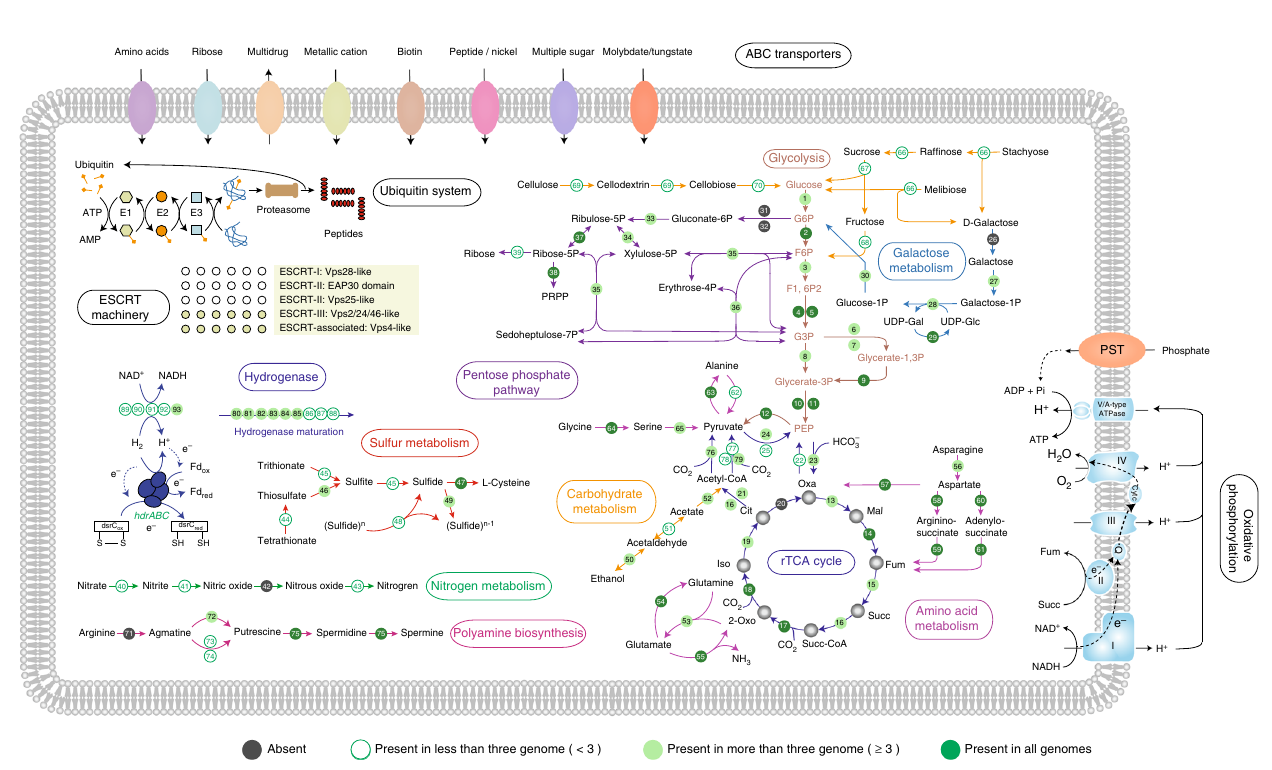
Fig. 2 Overview of metabolic potentials in Aigarchaeota. Genes related to glycolysis, galactose metabolism, roTCA cycle, the pentose phosphate pathway, the pyruvate metabolism, beta-oxidation of fatty acids, oxidative phosphorylation chain, protein biosynthesis-related pathway, membrane transporters, and ubiquitin system are shown. Green solid circles represent genes present in all six aigarchaeal genome bins. Green hollow circles represent genes occurring in one to fi ve bins. Gray solid circles represent genes absent in all bins. For full names and copy numbers of the genes in number see Supplementary Data 1. roTCA reversed oxidative tricarboxylic acid cycle; ESCRT the endosomal sorting complexes required for transport, G6p glucose 6-phosphate, F6P fructose 6-phosphate; F1,6P 2 fructose 1,6-bisphosphate, PEP